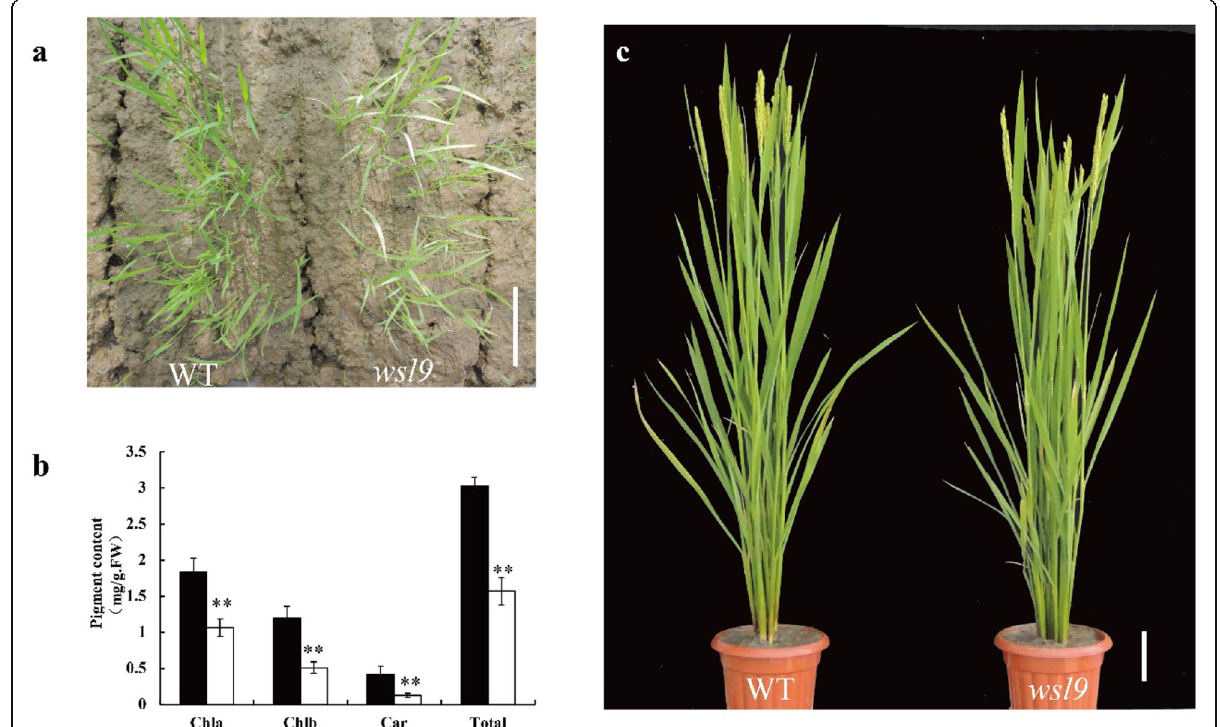
Fig. 1 Phenotypic characteristics of wild-type and wsl9 mutant. a Phenotypes of WT (left) and wsl9 mutant (right) seedlings in the field 2 weeks after seeding. b Leaf pigment contents of field-grown WT and wsl9 seedlings at 2 weeks post-seeding. c Phenotypes of WT (left) and wsl9 (right) plants at 10 days post-heading. (Student ’ s t -tests, **, P < 0.01). Scale bars, 10 cm in a and